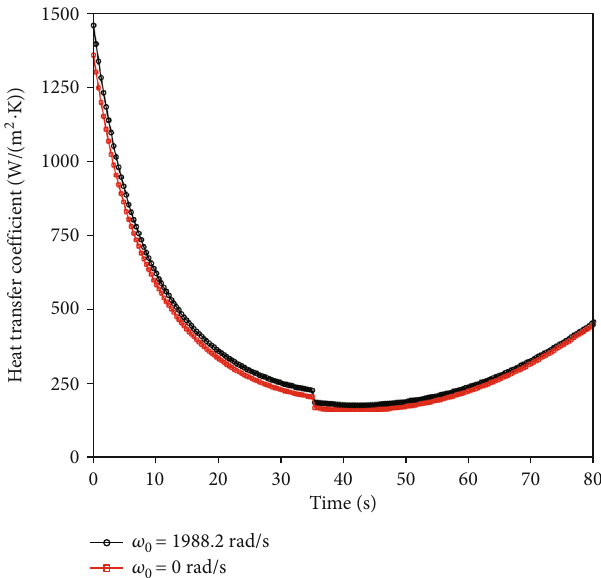
Figure 11: Average coe ffi cients of convection heat transfer at di ff erent initial rotational speeds.